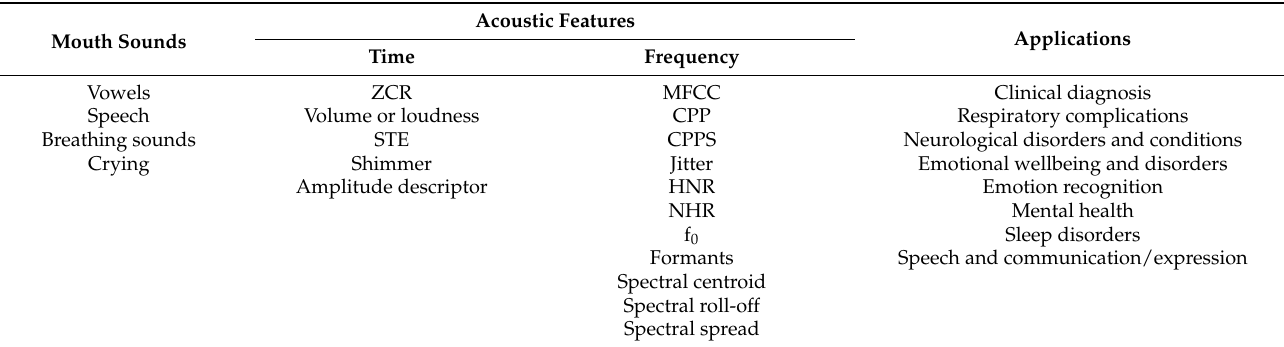
Table 2. Summary of important aspects regarding mouth sounds, analyzed acoustics features, and